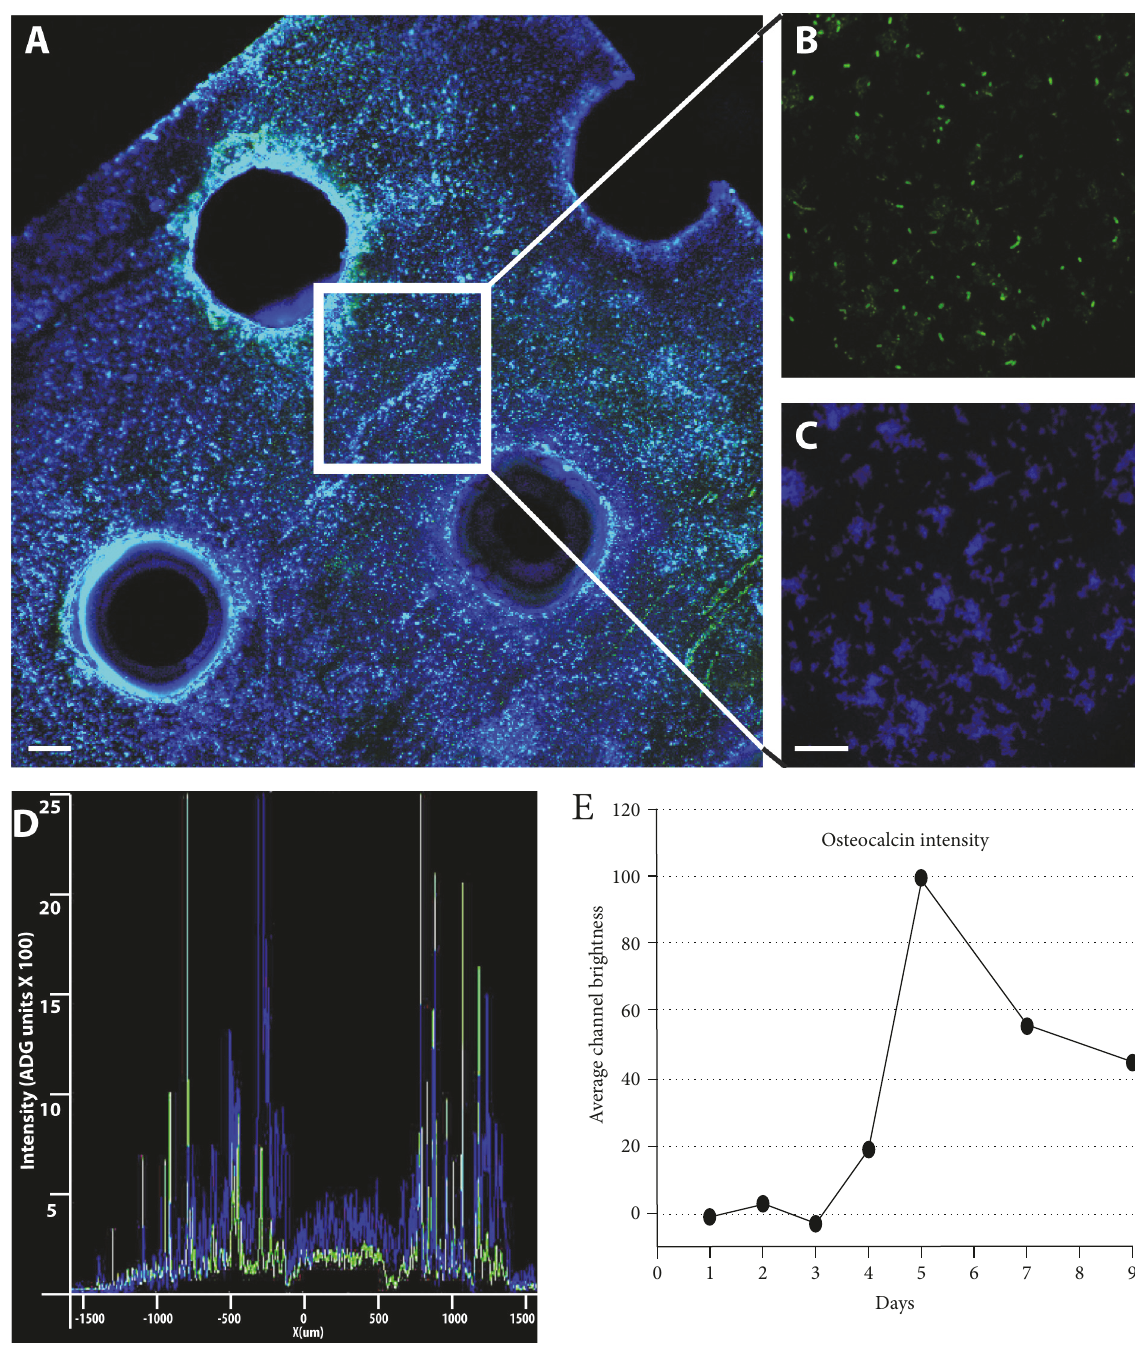
Figure 6: Analysis to detect BDSC capacity to di ff erentiate on titanium sca ff olds. (A) Merge analysis on type 2 titanium sca ff old by osteocalcin expression ((B) osteocalcin green) and nuclear staining ((C) DAPI blue) to demonstrate BDSCs osteogenic di ff erentiation. (D) shows a graphical representation of the two channel light intensity signals (expressed in ADG units × 100). It is evident how the blue peaks (nuclear signal) overlap the green peaks (osteocalcin signal). (E) shows time course experiments for osteocalcin expression (expressed as average channel brightness) ((A): bar =200 μ m, (B), (C): bar =50 μ